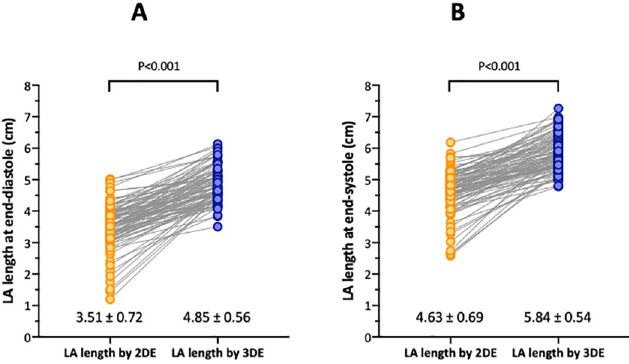
Fig 6. A paired comparison of left atrial length between 2DE and 3DE. A: End-diastole. B: End-systole.